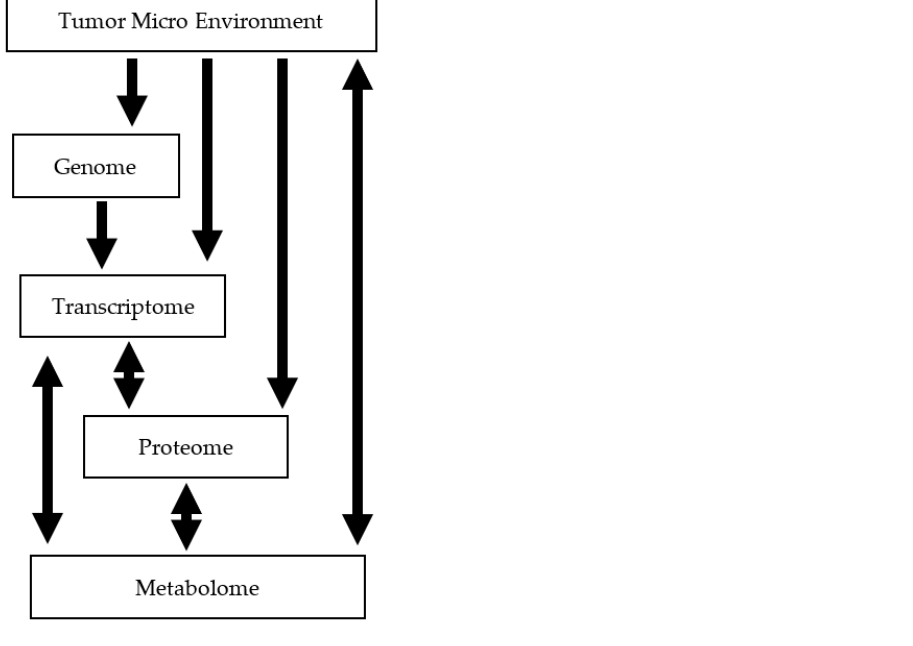
Figure 1. The metabolomic profile, or ‘Metabolome,’ is downstream of all other factors. Arrows in- dicate reciprocal/unidirectional modulation of factors. Adopted from Griffen et al. [2].